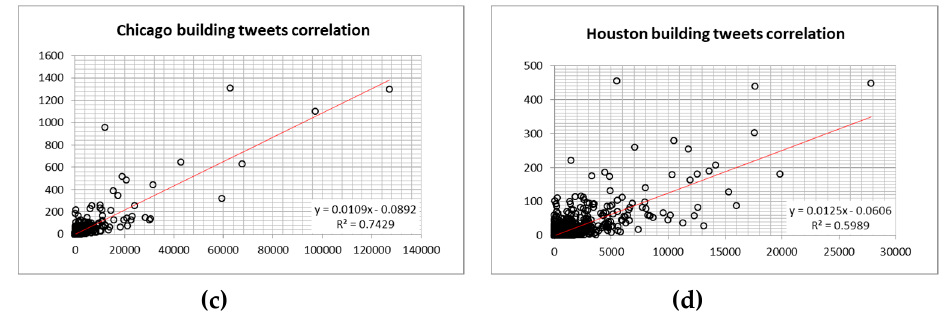
Figure 6. The correlation between the number of buildings and number of tweets inside the hotspots generated in the four largest natural cities. ( a ) Los Angeles; ( b ) New York; ( c ) Chicago; and ( d ) Houston.